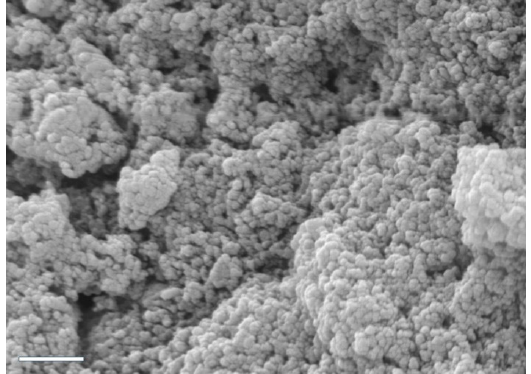
Figure 2. SEM micrograph of CS/hsDNA particles (CS molecular weight = 50 kDa, N/P ratio = 10). Scale bar: 2